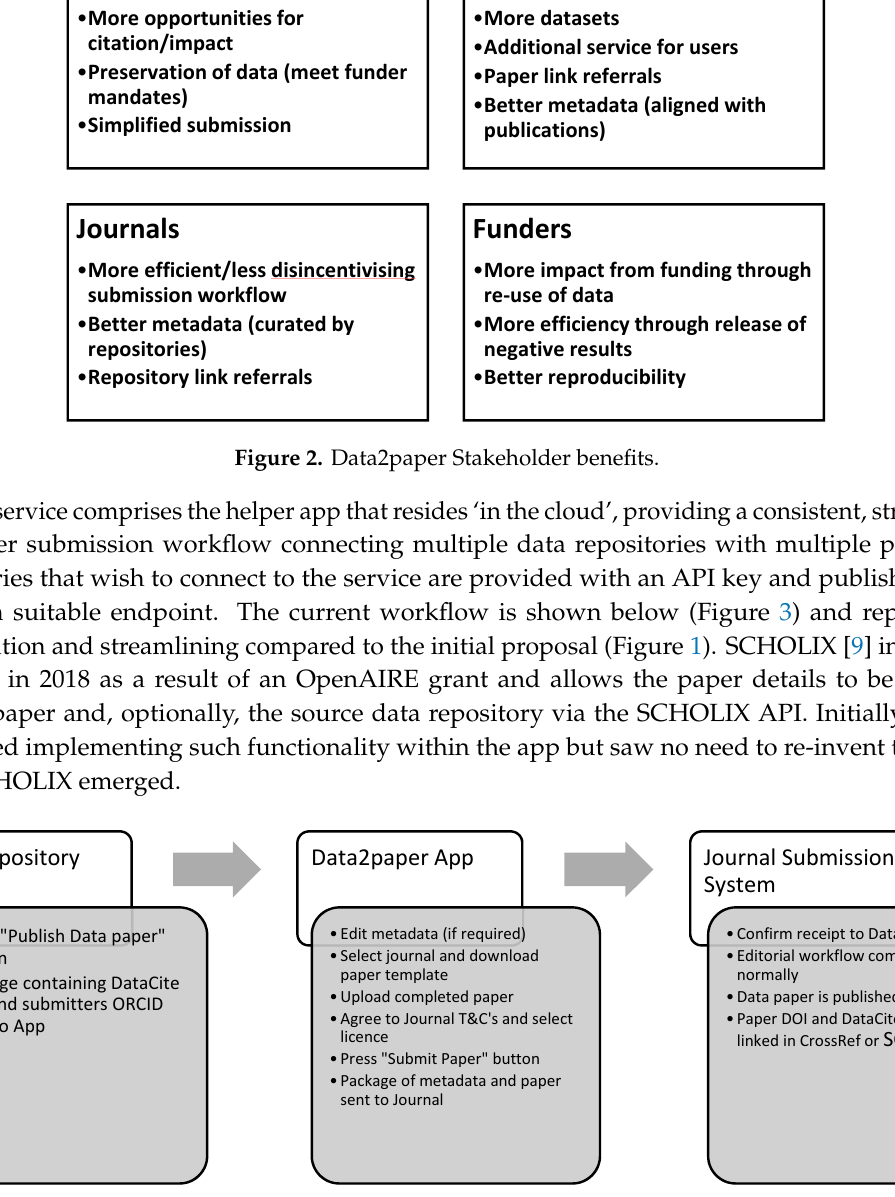
Figure 3. Data2paper Workflow Figure 3 . Data2paper Workflow Schematic . Figure 3 . Data2paper Workflow Schematic .